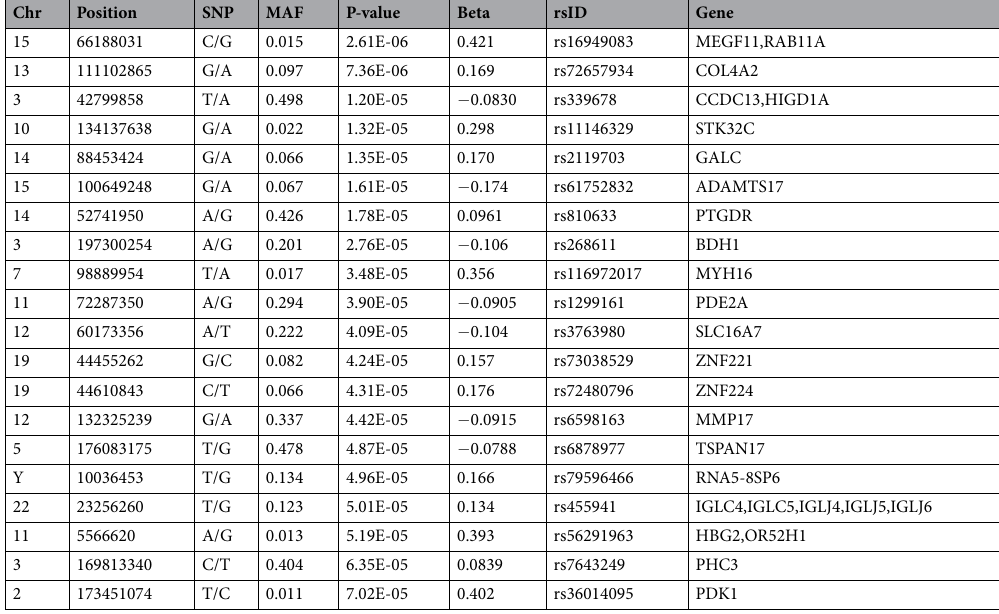
Table 2. Top hits for single variant analysis (MAF >